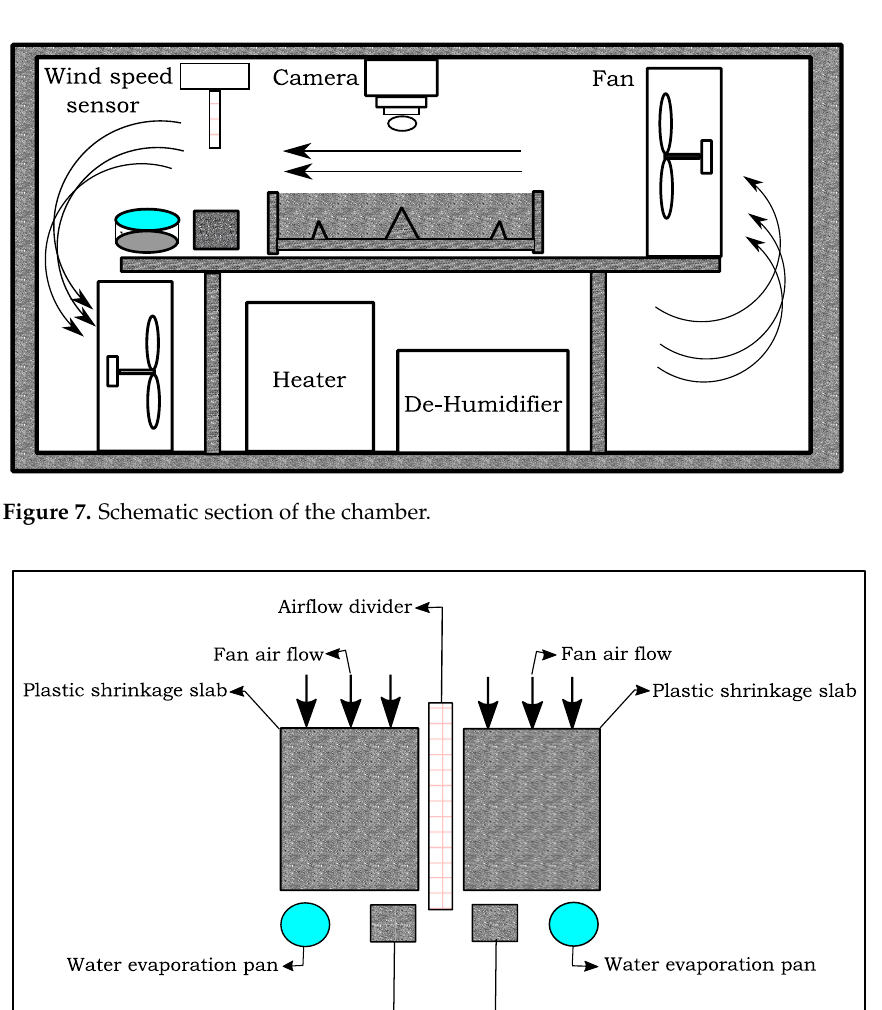
Figure 8. Schematic plan of the contents of the chamber.